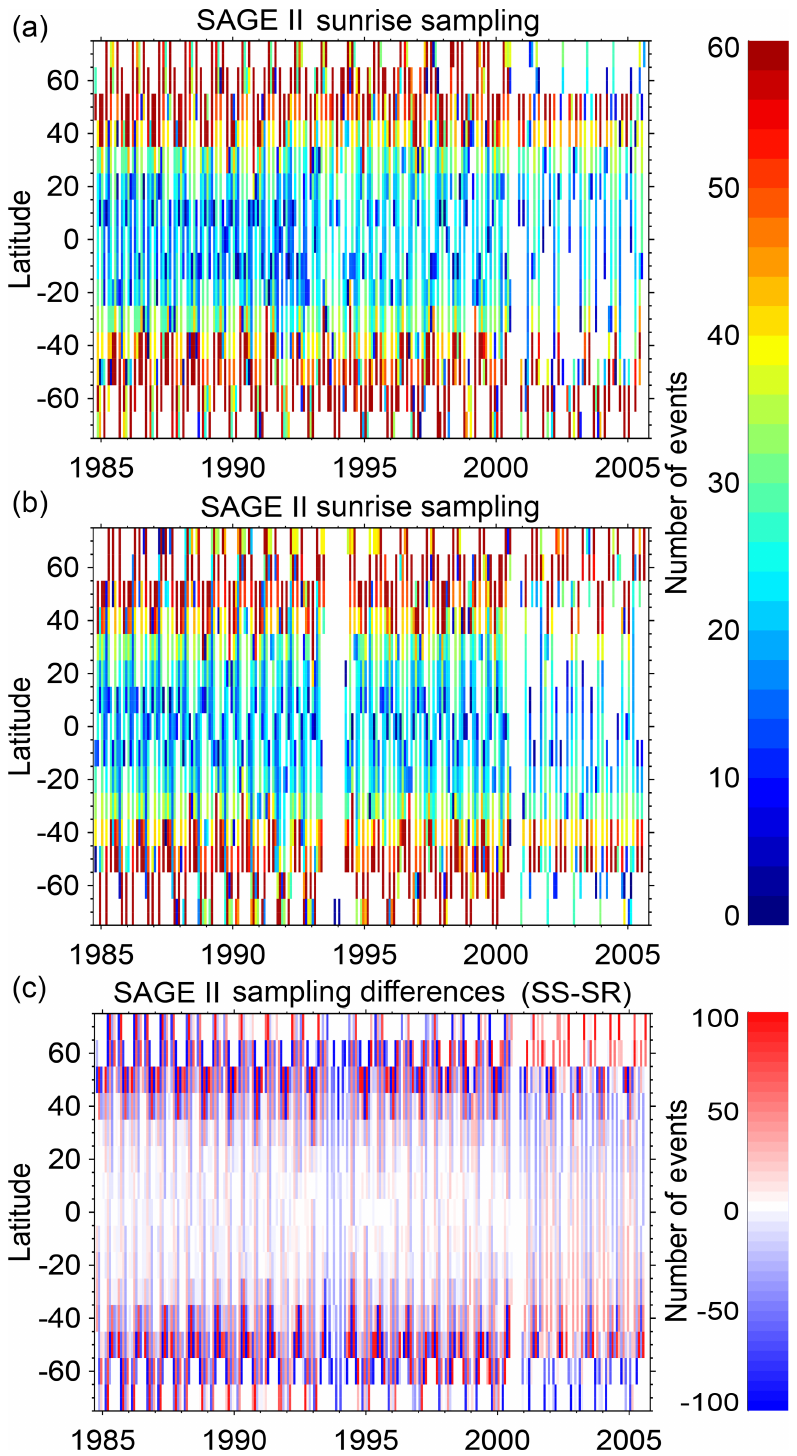
Figure 8. Monthly zonal sampling for SAGE II separated by local event type (a, b) . There was a problem with the battery that caused shortened sunset events between mid-1993 and mid-1994 and an issue with the azimuthal pointing system after late-2000 that caused a hemispheric asymmetry in sampling. Panel (c) is the difference between the (a) and (b) panels, revealing the rapid oscillation between SR- and SS-dominated months as well as whole periods dominated by one event